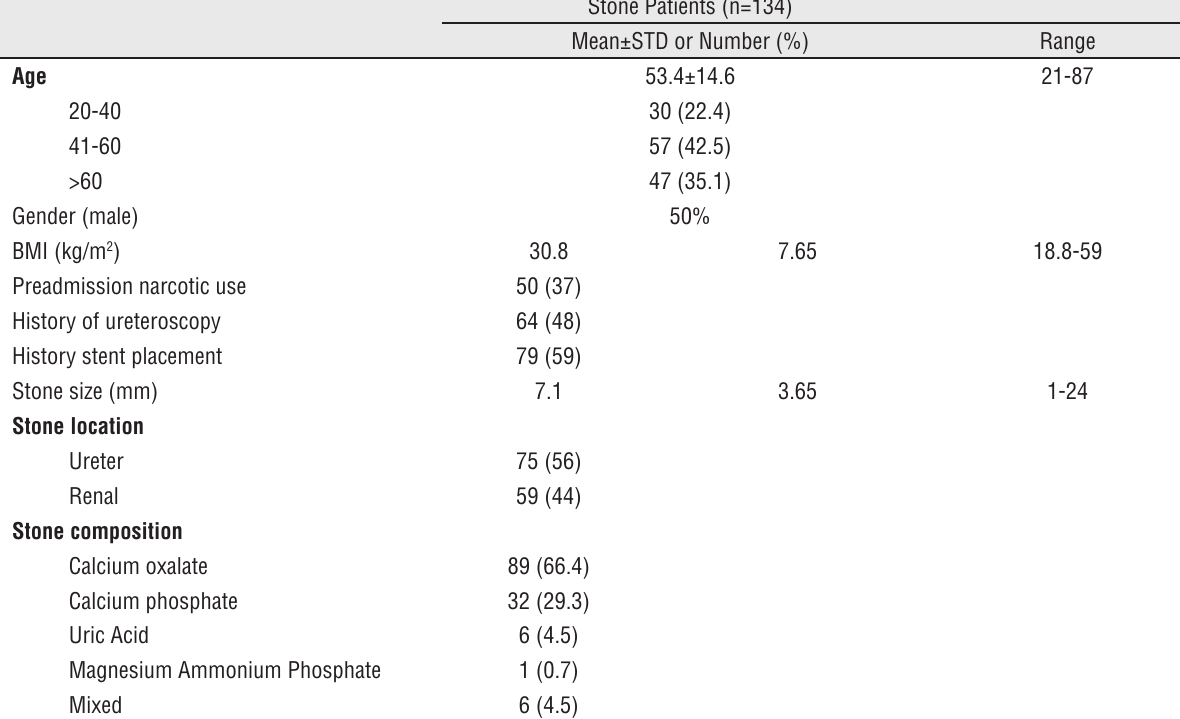
Table 1 - patient and stone Characteristics.